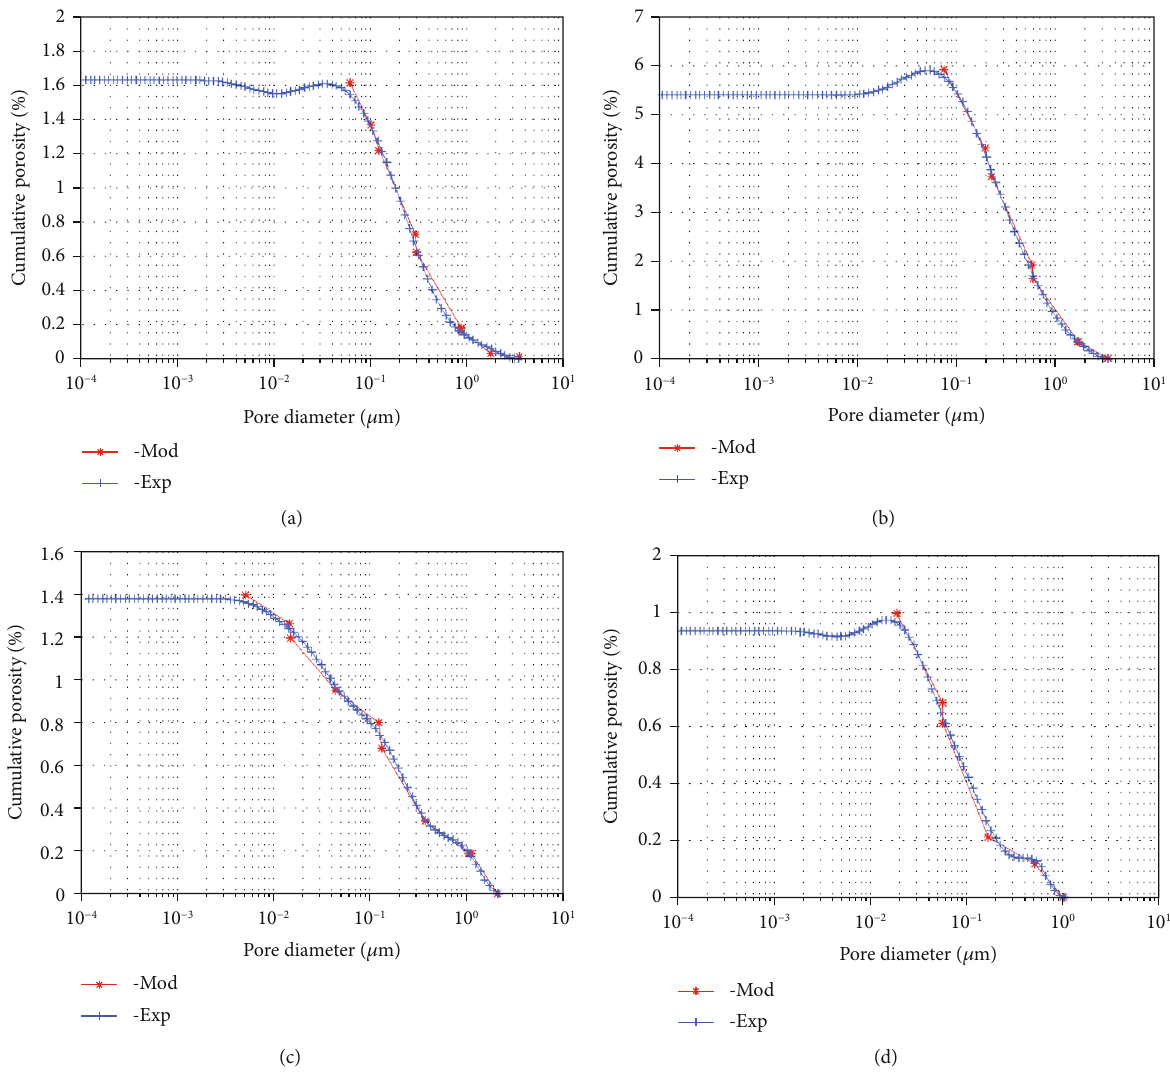
Figure 9: Images showing the IFU model fi tting pore size distribution curve of free fl uid: (a) B64-3, (b) B64-38, (c) M101-2-2, and (d) M5-6.